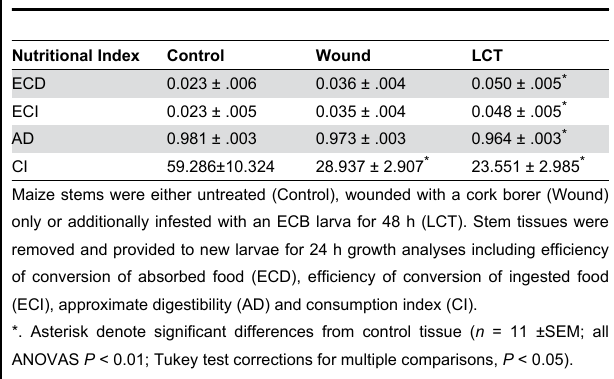
Table 1. Nutritional indices for ECB larvae on maize